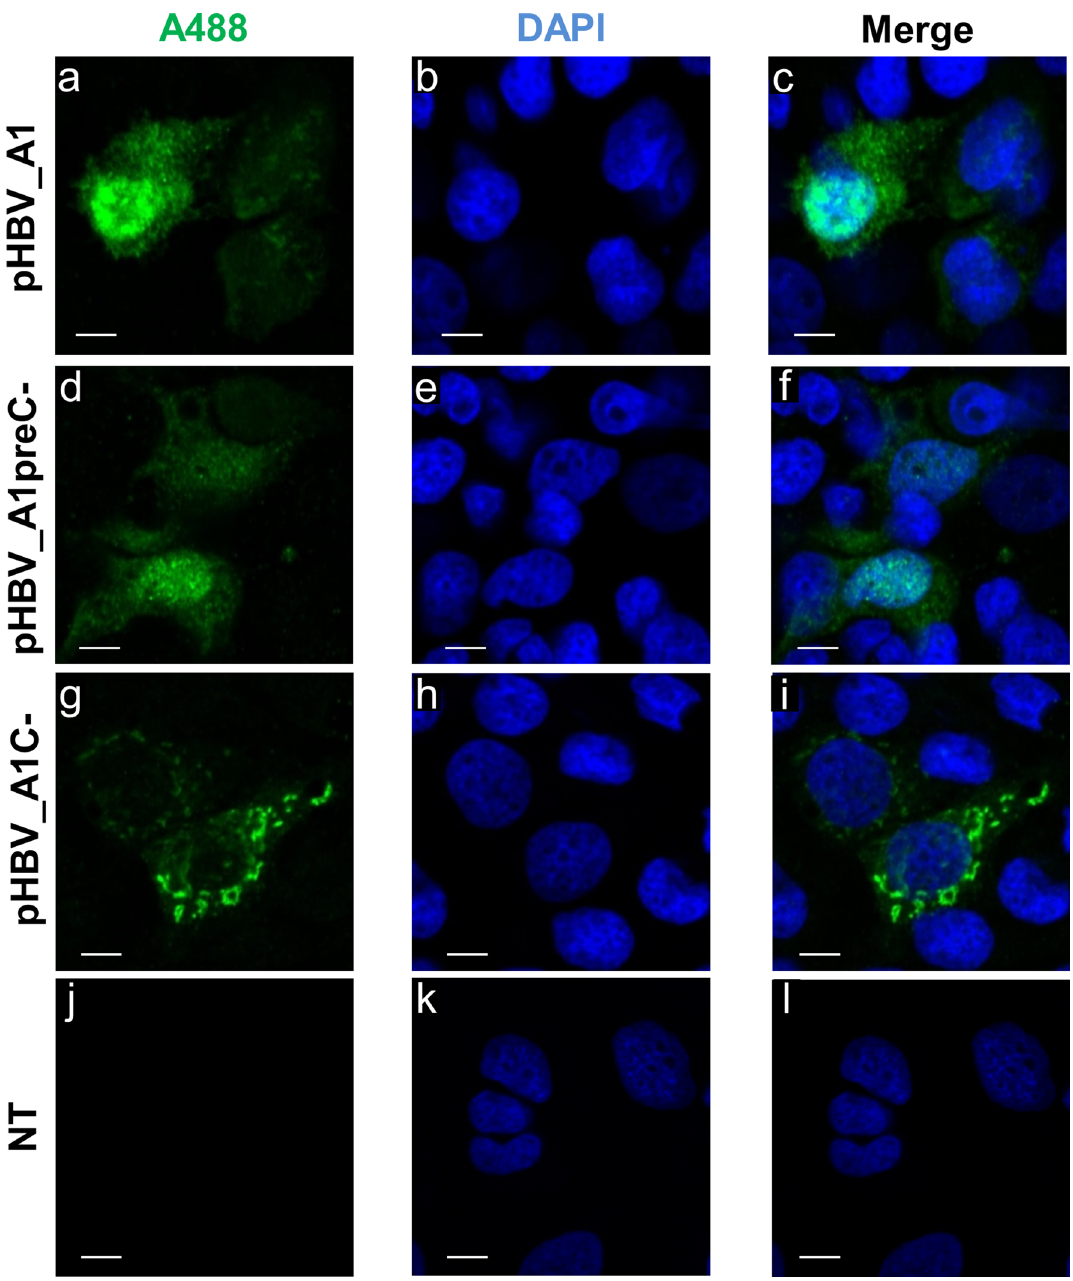
Figure 5. Intracellular localization of HBeAg and its precursors following transfection with a subgenotype A1 replication competent clone. Cells were transfected with pHBV_A1, pHBV_A1preC- (HBV A1 replication competent clone where ATG of precore has been mutated) and pHBV_A1C- (HBV A1 replication competent clone where ATG of core has been mutated). Cells were immunostained with a polyclonal rabbit anti-HBc antibody (DAKO, ( a,d,g,j ) and viewed with a confocal microscope on day 3 post-transfection. NT: non- transfected cells ( j,k,l ). Nuclei were visualized by DAPI staining ( b,e,h,k ); ( c,f,i,l ): merge. Bars, 10